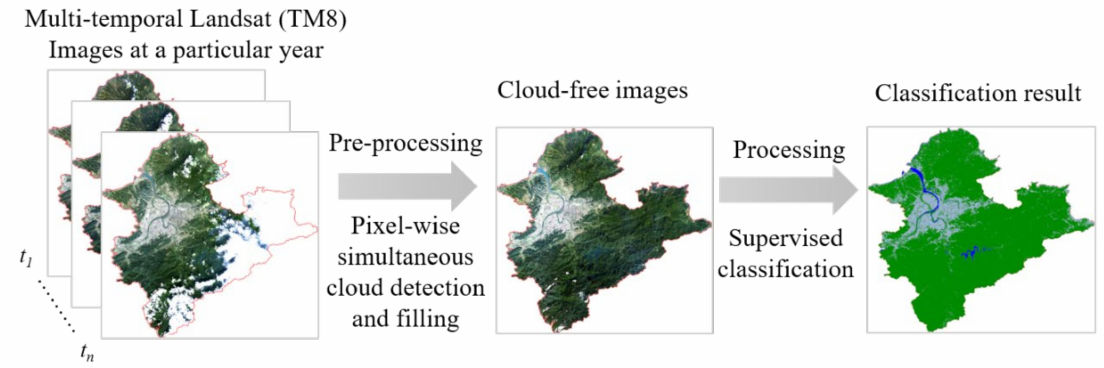
Figure 3. Workflow of cloud-free image generation and classification. This process involves mul- tiple steps, including image acquisition, pre-processing and analysis, n represents the number of used